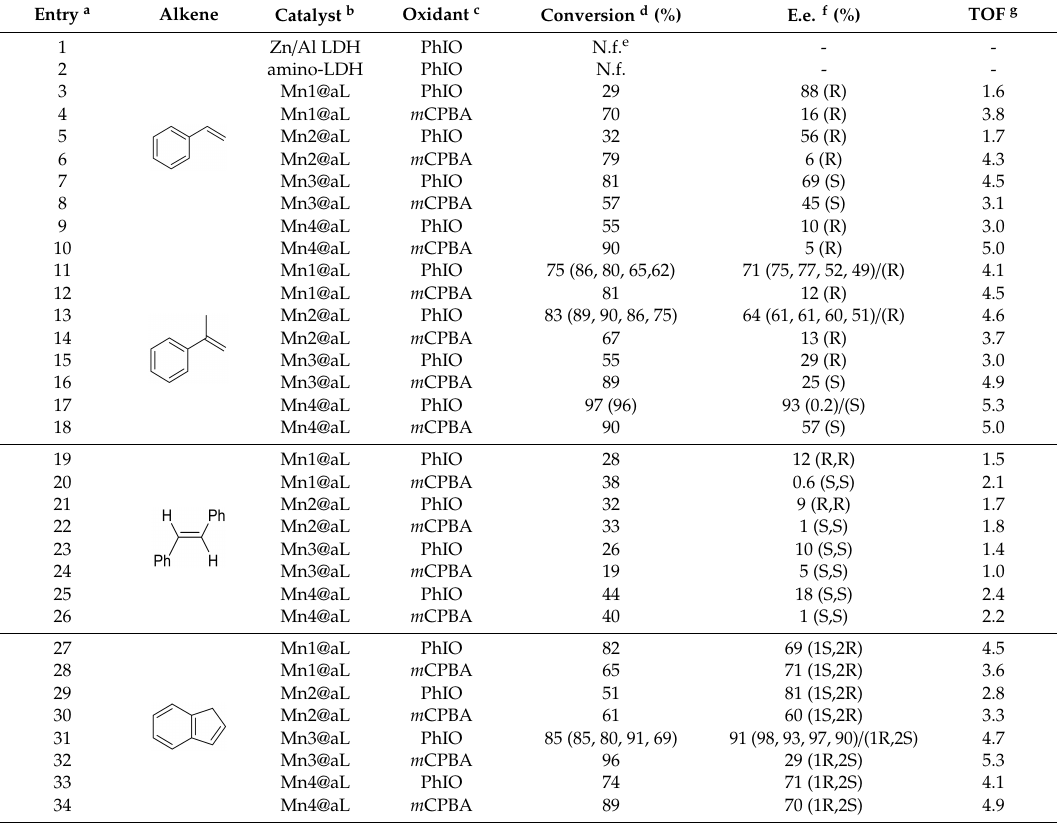
Table 6. Asymmetric epoxidation of unfunctionalized alkenes catalyzed by Zn / Al LDH-supported (tartrate-salen)Mn(III)